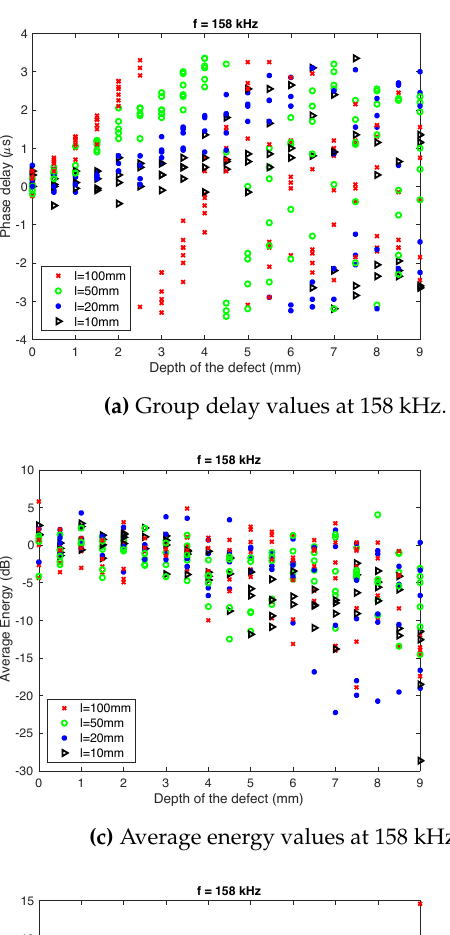
Figure 6. Model of the simulated defects.